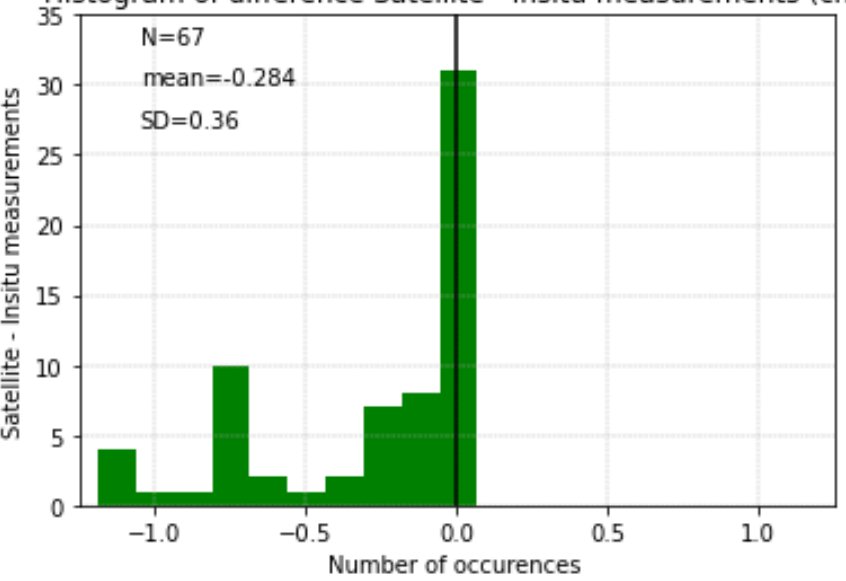
Figure 2. Histogram of absolute differences between satellite snow height and in-situ snow height, calculated for all collocated cases.